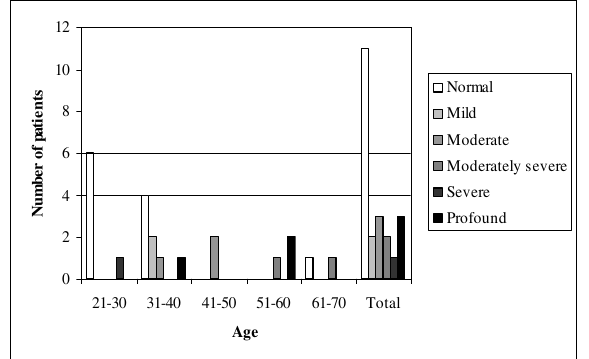
Figure 1 Degree of hearing loss as a function of age in 22 patients affected with Fabry disease. Impairment was classified using pure-tone thresholds (0.5, 1, and 2 kHz; PTAs) on the more affected ear without any consideration with the age or higher frequencies (4 and 8